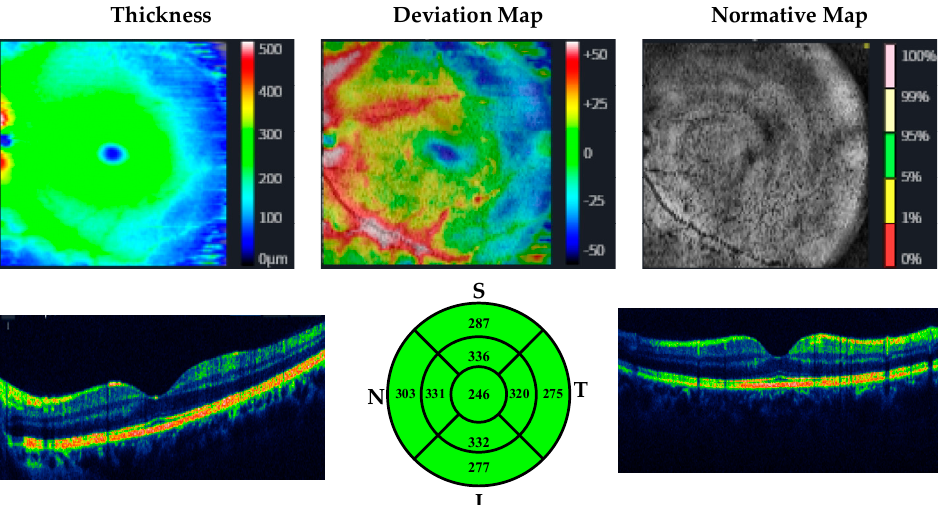
Figure 1. OCT analysis of the macula in a healthy participant.